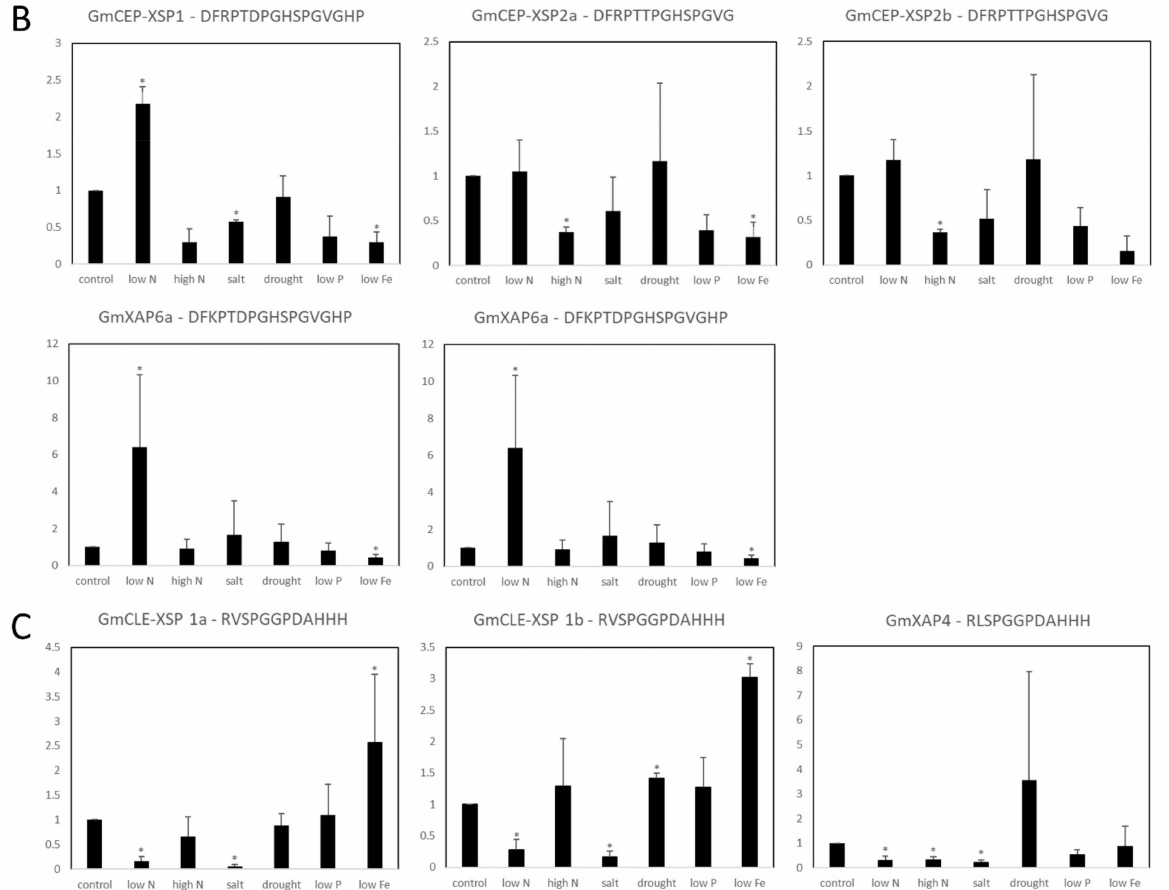
Figure 2. Relative expression levels of xylem sap peptide precursor genes in soybean roots under various abiotic stress conditions: ( A ) tyrosine-sulfated peptides; ( B ) C-terminally encoded peptides (CEPs); ( C ) CLAVATA3/embryo surrounding region-related peptides (CLEs). The soybean gene Bic-C2 was used as a reference gene for normalization. The relative expression values are based on expression in the control plants. The error bars indicate standard deviation ( n = 3). Statistical significance was evaluated by Student’s t-test, and significant differences ( p -value < 0.05) between the treatment and control plants are indicated by asterisks